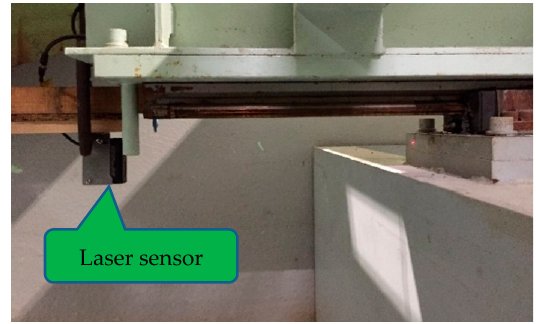
Figure 2. Laser sensor attached to the base frame to measure piston motion.